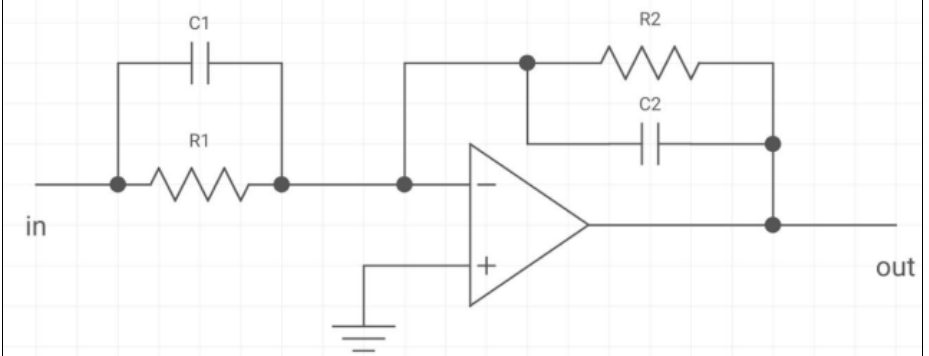
Figure 3: Lag Compensator (R1C1<